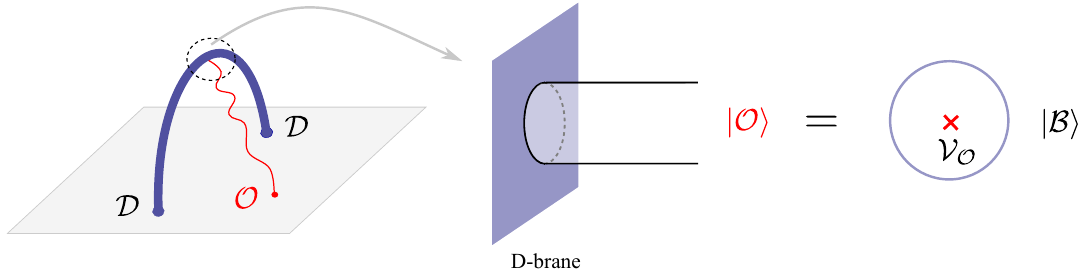
Figure 7 . The AdS description of the three-point function. The determinant operators D corre- spond to a geodesics of the Giant Graviton (denoted by a thick blue curve) while the single-trace operator corresponds to a closed string (denoted by a red wavy line). The worldsheet of the closed string has a boundary at which it gets attached to the Giant Graviton D-brane. It can be viewed either as a disk with one puncture (the right (cid:12)gure) or as a semi-in(cid:12)nite cylinder (the middle (cid:12)gure). In the latter description, the three-point function corresponds to an overlap between the boundary state hBj and a closed string state jOi